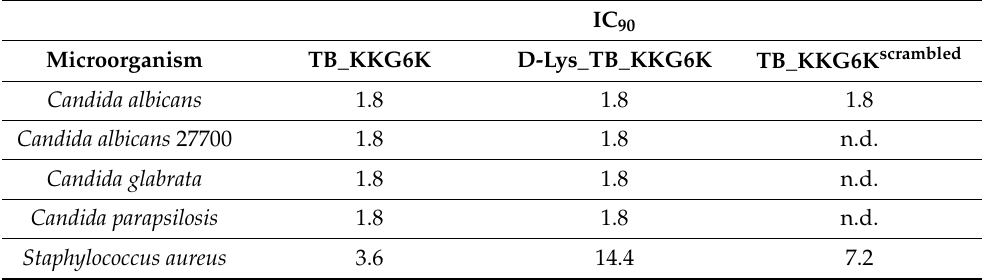
Table 1. Inhibitory concentrations (IC 90 , in µM) of the TB peptide analogs against microorganisms § .